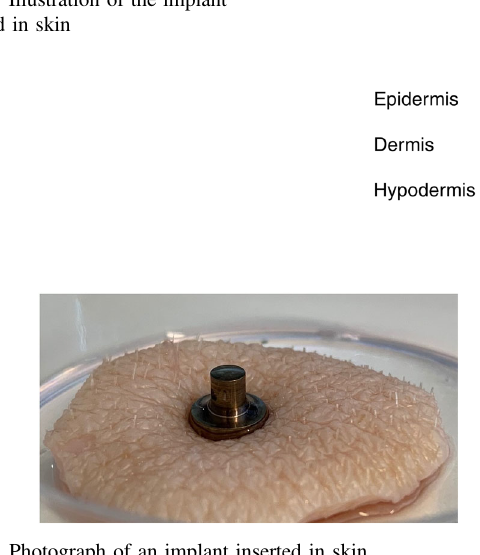
Fig. 2 Illustration of the implant placed in skin